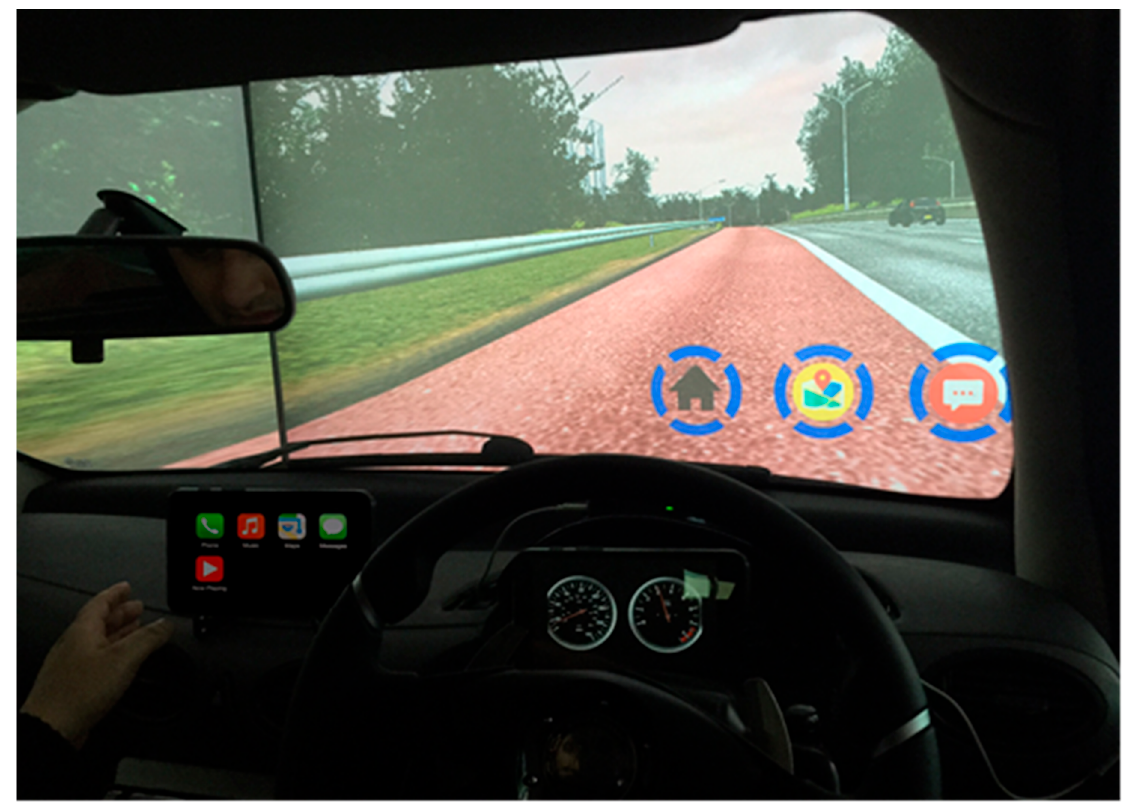
Figure 1. Screenshot of the fully functional Augmented Reality (AR) Head-Up Display (HUD) and conventional Head-Down Display (HDD) interfaces in the Virtual Reality (VR) driving simulator.